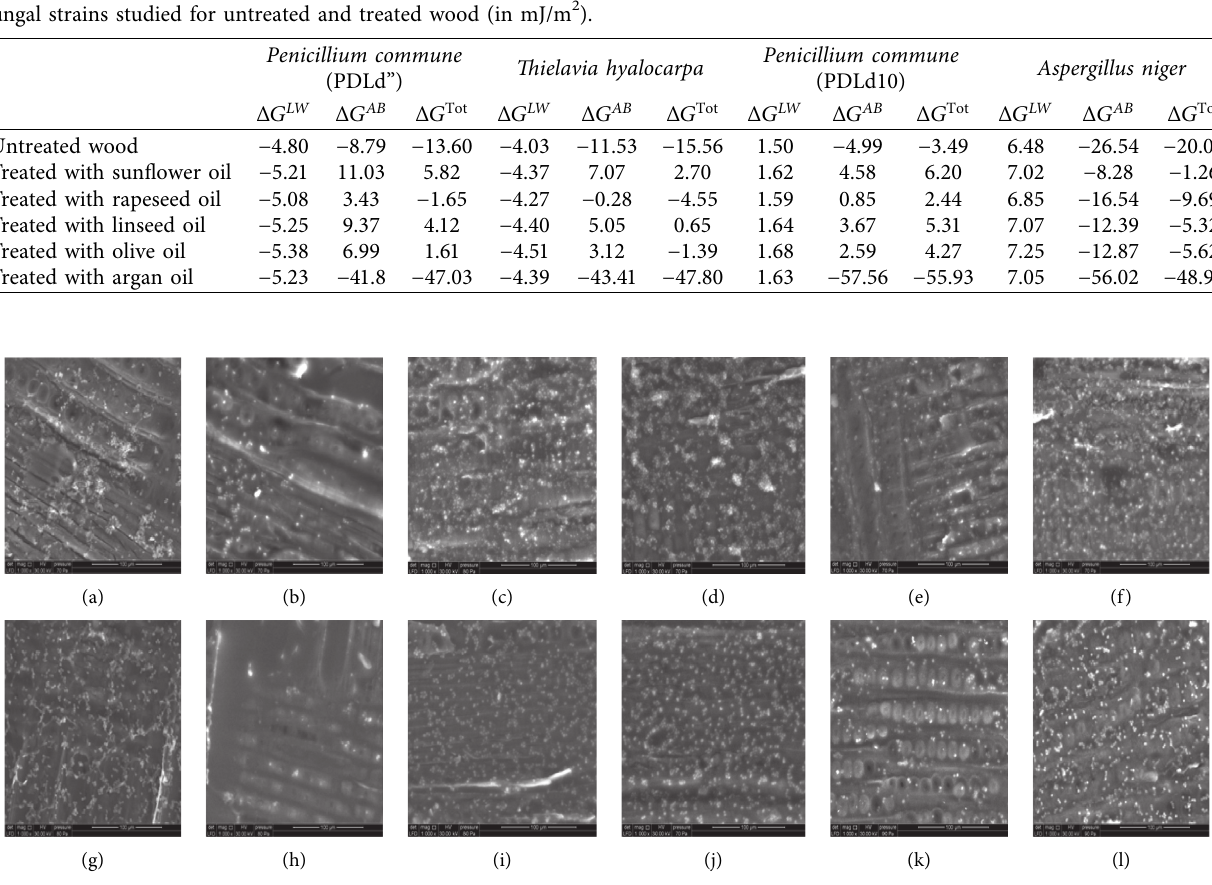
Figure 1: Electron micrographs of Penicillium commune (PDLd”) (a–f) and Thielavia hyalocarpa (g–l) spores adhered on to untreated and treated wood, visualized by environmental scanning electron microscopy. (a, g) untreated wood, (b, h) olive oil treatment, (c, i) sunflower oil treatment, (d, j) rapeseed oil treatment, (e, k) linseed oil treatment, and (f, l) argan oil